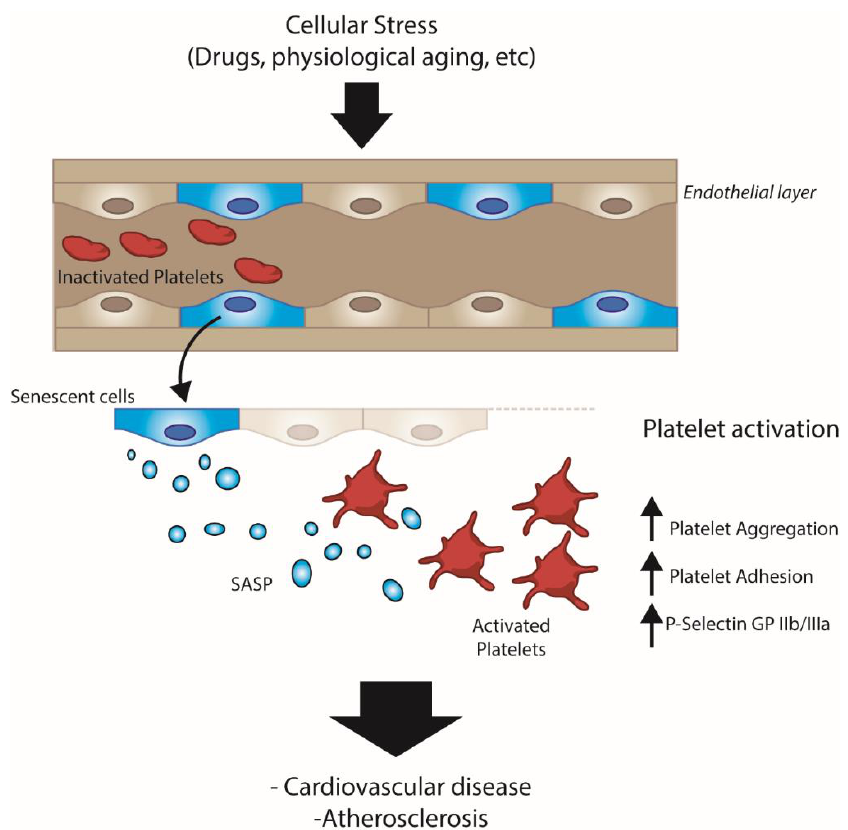
Figure 5. General scheme depicting the SASP-dependent interactions between senescent endothelial cells and platelets in vivo .